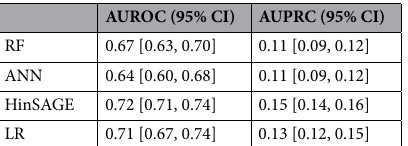
Table 1. Comparison of different model performances for baseline models and HinSAGE